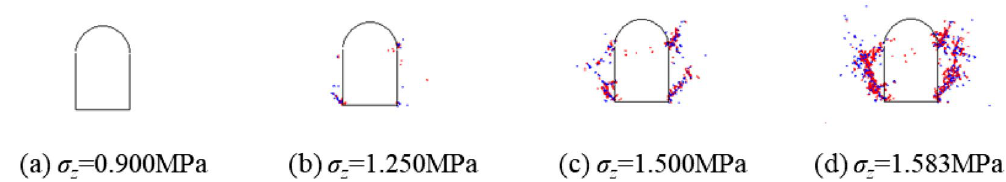
Figure 22. Damage propagation during excavation unloading with imposed vertical stress of 0.900 MPa.